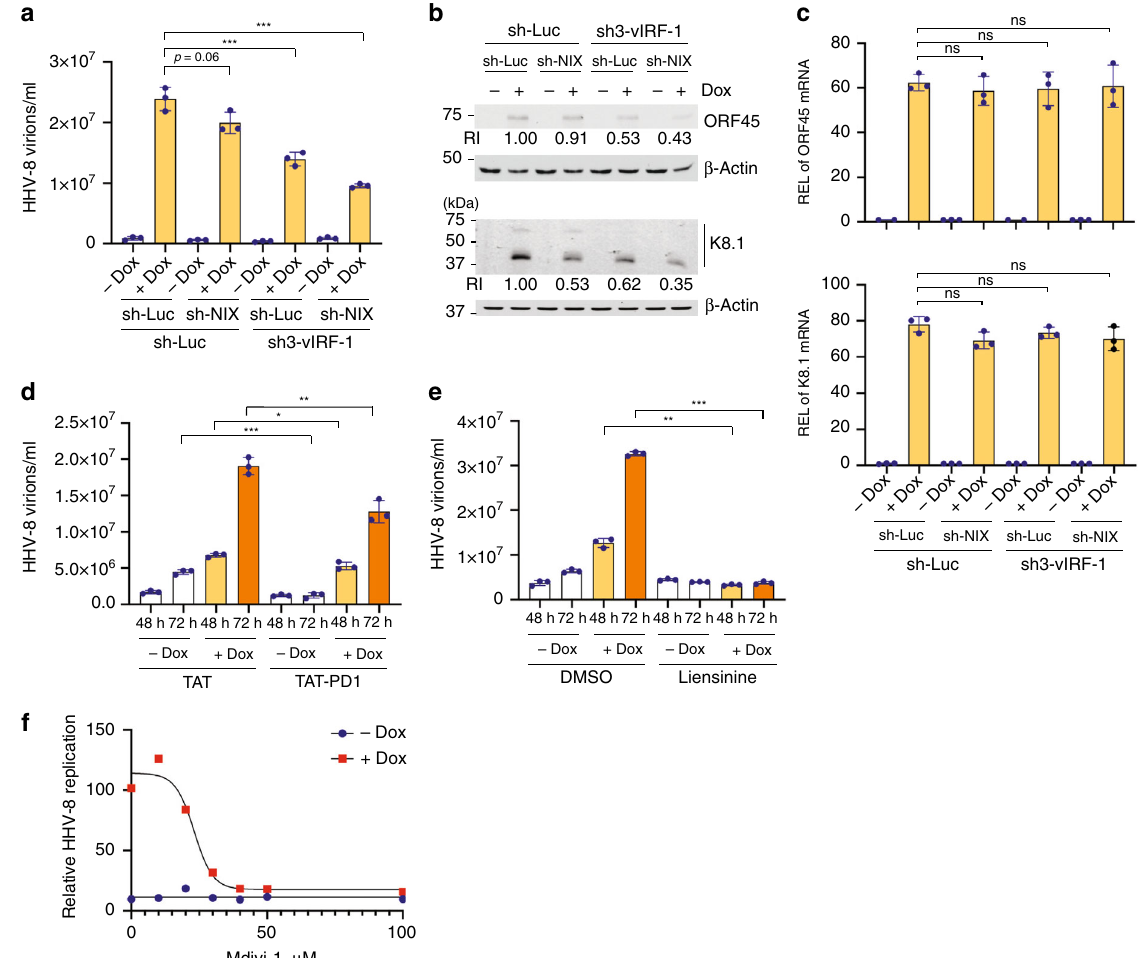
Fig. 8 Mitophagy plays an essential role in HHV-8 productive replication. a RT-qPCR analysis of the copy number of encapsidated viral genome present in the culture media of control (sh-Luc) and vIRF-1- and/or NIX-depleted iBCBL-1 cells that were left untreated or treated with Dox for 4 days. Mean ± SD, n = 3. The p -value was determined by matched pair t -test (*** p < 0.001). b Immunoblots of total-cell extracts derived from the same cultures as above ( a ) using antibodies to lytic antigens ORF45 and K8.1. The relative band intensities (RI) normalized to the loading control β -Actin are displayed beneath the corresponding panel. c RT-qPCR analysis of the mRNA expression of ORF45 and K8.1 in control (sh-Luc) and vIRF-1- and/or NIX-depleted iBCBL-1 cells that were left untreated or treated with Dox for 4 days. The relative expression levels (REL) normalized to 18S rRNA was calculated by dividing Dox sample by no-Dox control in each cell line. Data represent the mean ± SD of four independent experiments ( n = 4). ns, not signi fi cant. d – f RT-qPCR analyses of encapsidated viral genome copy numbers in the media of iBCBL-1 cultures left untreated or treated with Dox for 2 days together with 10 µ M TAT or TAT- PD1 peptides ( d ), 20 µ M liensinine or vehicle (DMSO) ( e ), and Mdivi-1 ( f ) at the indicated concentrations. Mean ± SD, n = 3. The p- value was determined by matched pair t -test (* p < 0.05, ** p < 0.01, and *** p < 0.001). Source data are provided as a Source Data fi